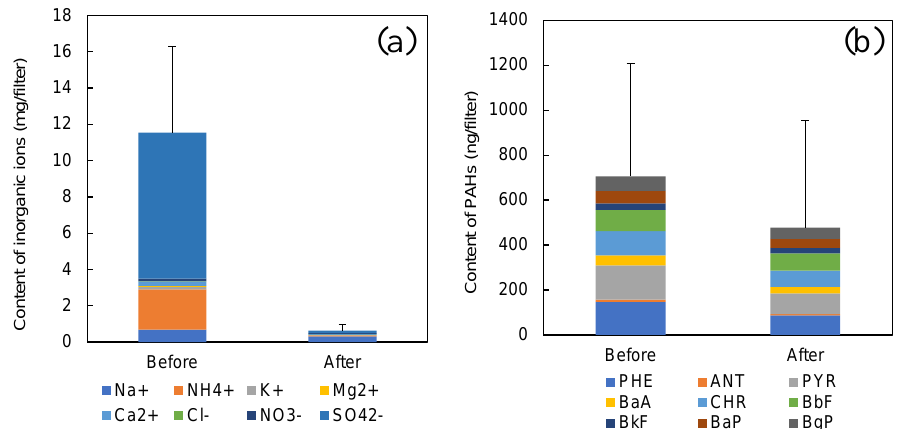
Figure 6. Effect of water treatment on the contents of ( a ) water-soluble ions and ( b ) nine PAHs. Bars show the averages and standard deviations of three repeat experiments.